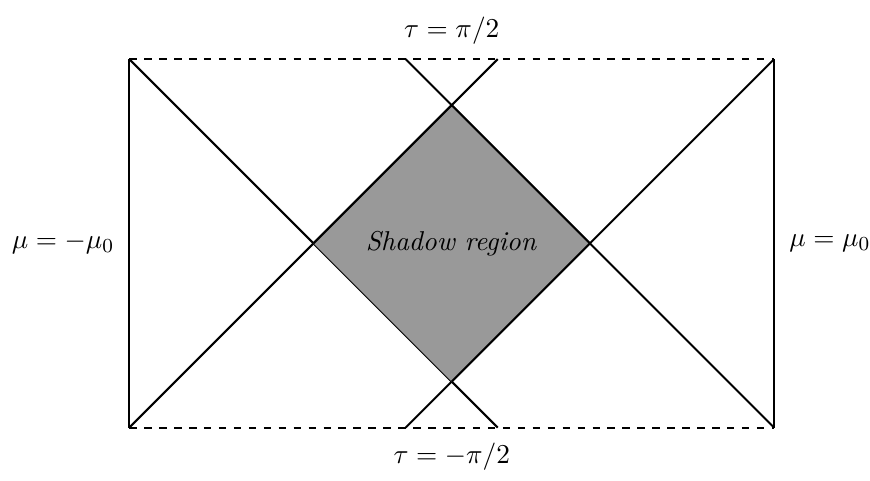
Figure 9 . Penrose diagram of the Janus deformation of the BTZ black hole. The µ variable runs along horizontal lines from − µ to µ , while τ runs vertically from − π/ 2 to π/ 2 . The shaded region 0 0 represents the so-called shadow region